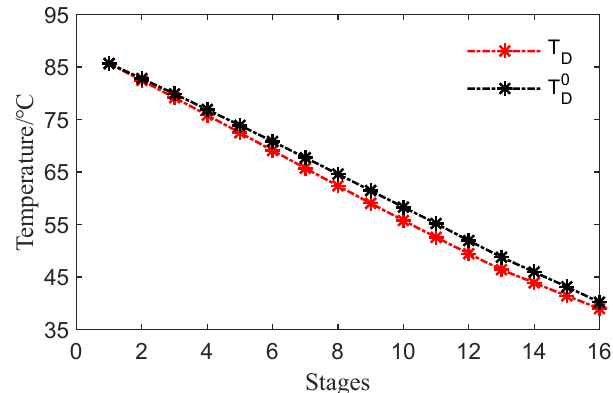
Figure 10. T Dj distribution comparison.